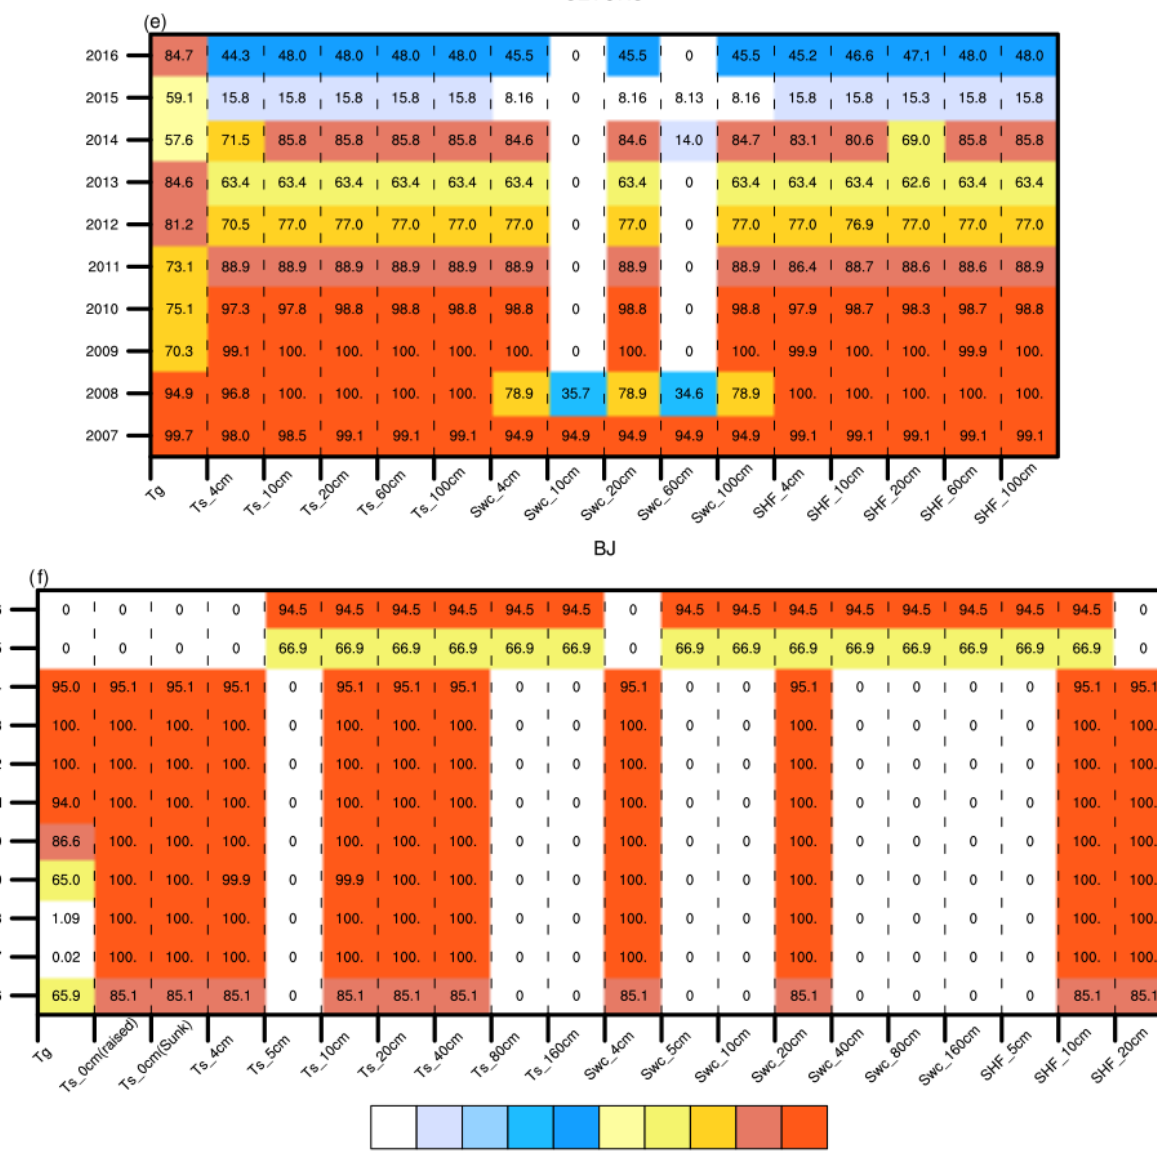
Figure A3. Same as Fig. A1, but for the soil hydrothermal observations. Ground temperature is represented by Tg, and the soil temperature and soil water content are expressed with Ts and SWC, respectively; SHF refers to the soil heat